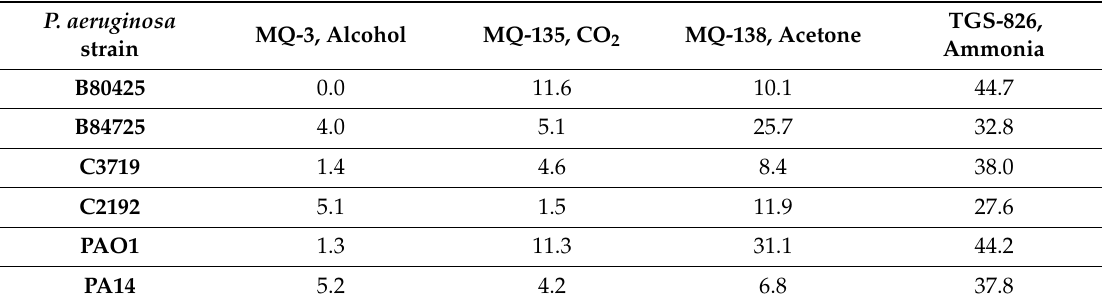
Table A1. Mean values of the P. aeruginosa solid samples at 2.5 mm.